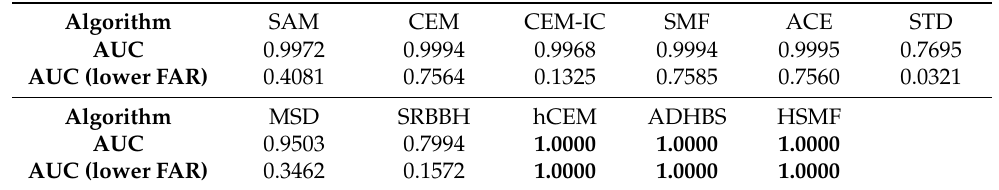
Table 2. AUC values and AUC values at lower FAR of all detectors for the Airport-Beach-Urban